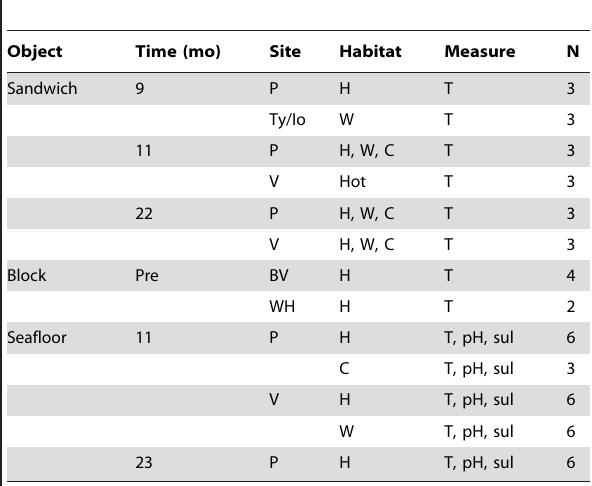
Table 1. Environmental conditions measured at colonization surfaces or on seafloor.